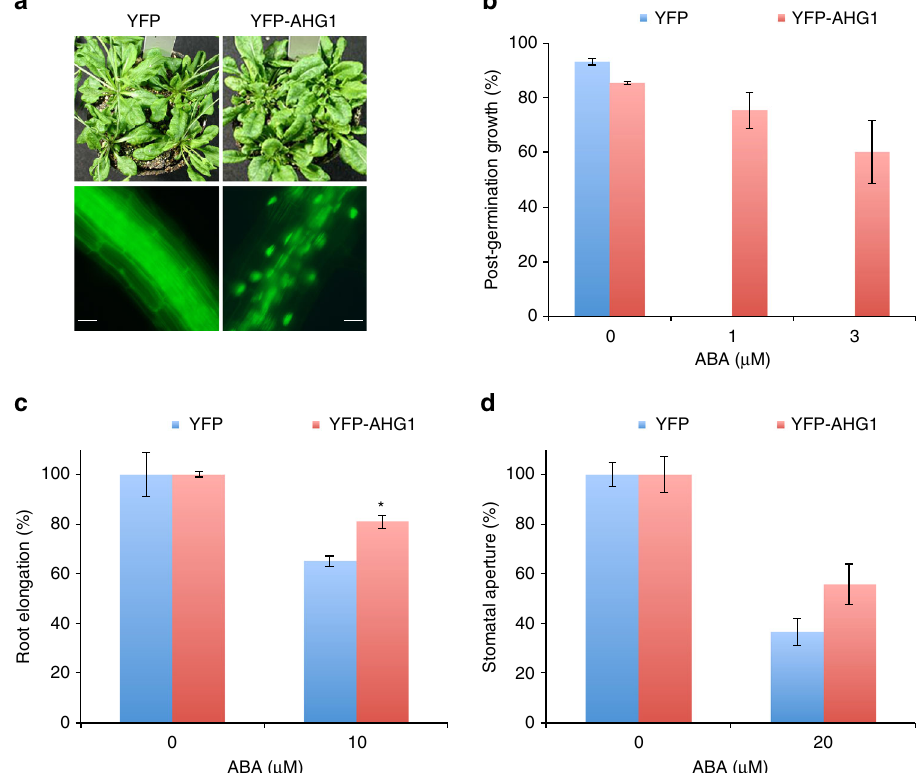
Fig. 3 Overexpression of YFP-AHG1 causes ABA insensitivity. a Morphology and subcellular localization of Arabidopsis plants overexpressing YFP (left) and YFP-AHG1 (right) at the rosette plant stage. Plants were grown for 6 weeks in soil. Scale bars, 20 μ m. b Post-germination growth ef fi ciencies of overexpressing YFP and YFP-AHG1 lines in the presence of various concentrations of ABA at 7 days after strati fi cation. Error bars show s.d. of three independent experiments using the same seed batch. c ABA-dependent root growth responses of overexpressing YFP and YFP-AHG1 lines. Seedlings were germinated and grown on hormone-free MS plates for 5 days and then transferred to MS plates with or without 10 µ M ABA. Root length was measured 4 days after the transfer. Error bars show s.e.m. of three independent experiments. An asterisk indicates signi fi cant difference between the corresponding values (* P < 0.05; Tukey – Kramer test). d ABA-induced stomatal closure in overexpressing YFP and YFP-AHG1 lines. The epidermal tissues isolated from dark-adapted 4-to 6-week-old plants were incubated in basal buffer (5 mM MES-BTP pH 6.5, 50 mM KCl, and 0.1 mM CaCl 2 ). Pre-illuminated epidermal tissues were incubated under light (red light at 50 µ mol m − 2 s − 1 and blue light at 10 µ mol m − 2 s − 1 ) for 2.5 h with or without 20 µ M ABA. Error bars show s. e.m. of three independent experiments (35 stomata per experiment and condition). No signi fi cant difference between the corresponding values ( P >